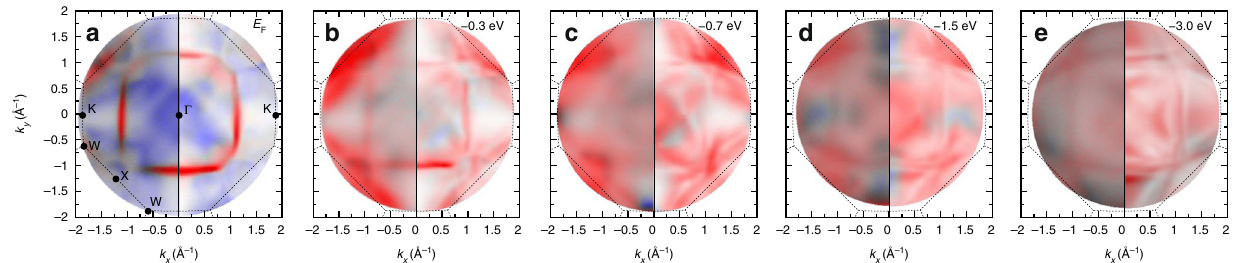
Fig. 4 Spin-resolved photoemission momentum maps. a – e Selected constant energy momentum discs from the spin-resolved experiment (left half of each panel) for hv = 50 eV at E F ( a ) to E F -3.0 eV ( e ). These sections are also marked in Fig. 2. Calculated photoemission maps at the same energies are displayed on the right half of each image. The calculations take into account the energy and momentum-dependent corrections for ℑ m Σ σ ( E ) and Re Σ σ ( k ). Red and blue colours correspond to the intensities of majority and minority electronic states, respectively